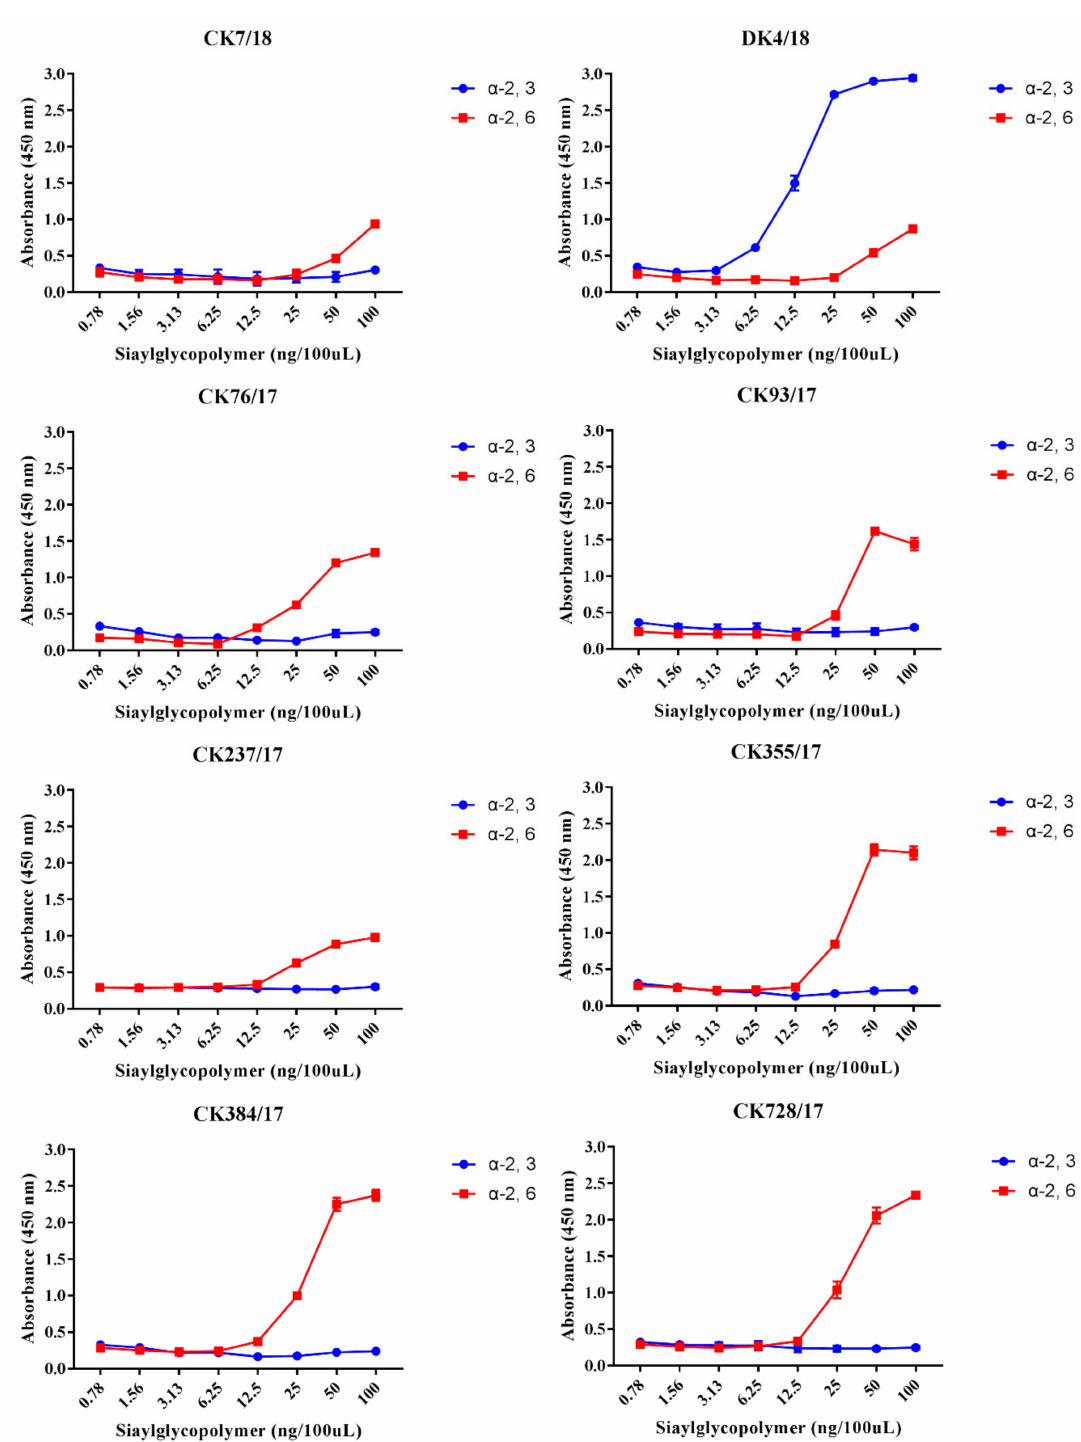
Figure 3. Receptor binding properties of the 8 H9N2 influenza viruses. Solid-phase binding assays for CK7 / 18, DK4 / 18, CK76 / 17, CK93 / 17, CK237 / 17, CK355 / 17, CK384 / 17, and CK728 / 17 to two di ff erent sialylglycopolymers (3’- SLN colored in blue and 6’- SLN colored in